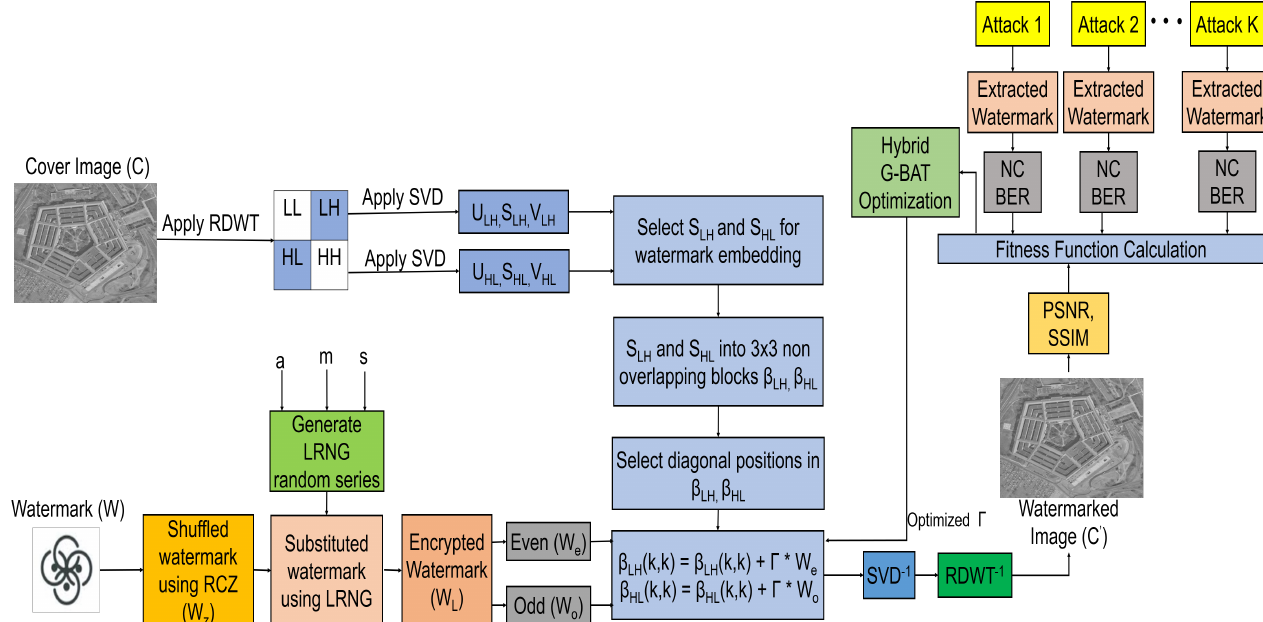
Figure 2. Block diagram for watermark encryption and